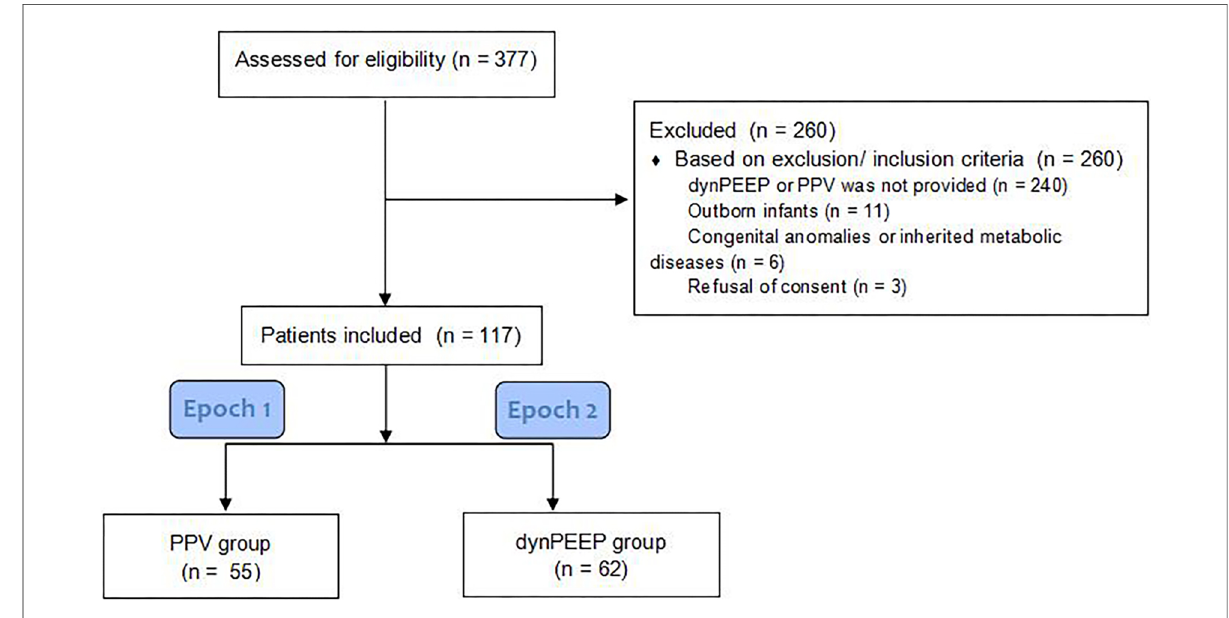
FIGURE 2 Flowchart of patient